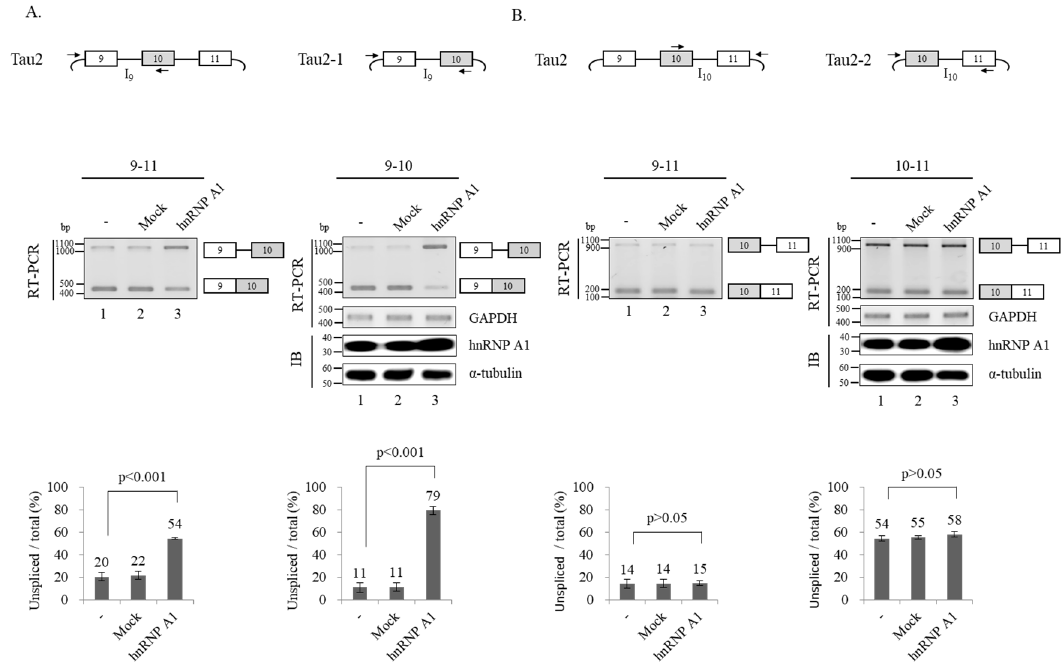
Figure 3. hnRNP A1 inhibits splicing of intron 9 but not intron 10. ( A ) (Upper panel) Schematic of Tau2 and Tau2–1 minigenes are shown. Primers used for RT-PCR are shown with arrows. (Middle panel) RT-PCR monitoring intron 9 splicing in Tau2 and Tau2–1 minigenes in hnRNP A1 or pcDNA transfected cells. Immunoblotting analysis of hnRNP A1 and α -tubulin in Tau-2–1 minigene splicing are shown. Immunoblotting in Tau2 minigene is shown in Figure 2B. (Lower panel) Bar charts of RT-PCR results are shown. ( B ) (Upper panel) Schematics of Tau2 and Tau2–2 minigenes are shown. Primers used for RT-PCR are shown with arrows. (Middle panel) RT-PCR monitoring intron 10 splicing in Tau2 and Tau2-1 minigenes in hnRNP A1 or pcDNA transfected cells. Immunoblotting analysis of hnRNP A1 and α -tubulin in Tau-2–2 minigene splicing are shown. Immunoblotting in Tau2 minigene is shown in Figure 2B. (Lower panel). Bar charts of RT-PCR results are shown.